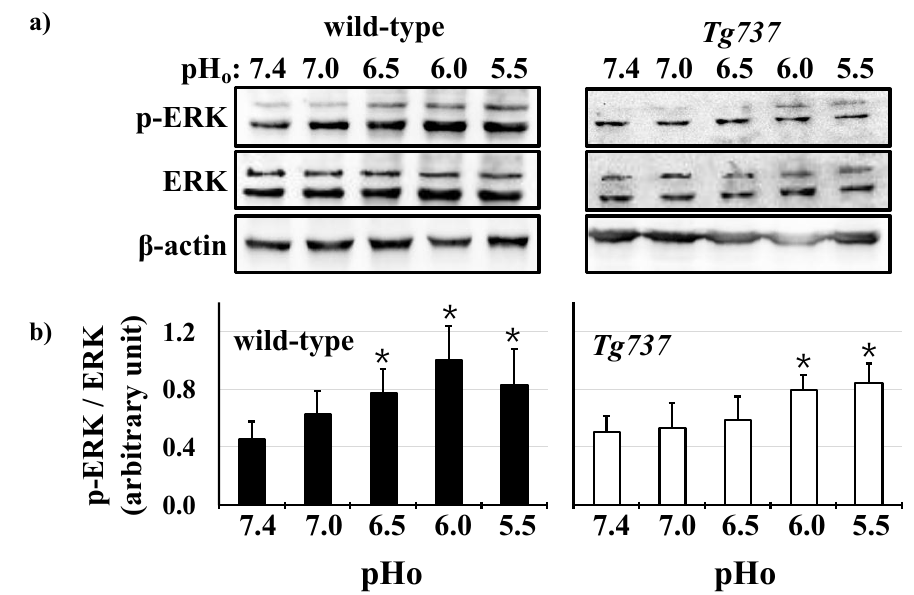
Figure 3. Decreasing extracellular pH increases ERK1 / 2 phosphorylation in wild-type and Tg737 cells. ( a ) Representative immunoblots show ERK1 / 2 phosphorylation in wild-type and Tg737 cells as they are exposed to media of decreasing extracellular pH (pH o ) from 7.4 to 5.5. ( b ) Bar graph shows the mean p-ERK / ERK, where wild-type cells phosphorylate ERK1 / 2 at pH of 6.5 while the same level of phosphorylation occurs at a lower pH of 6.0. * indicates p < 0.05 as compared to control pH o 7.4; N = 10 for wild-type cells and N = 10 for Tg737 cells.